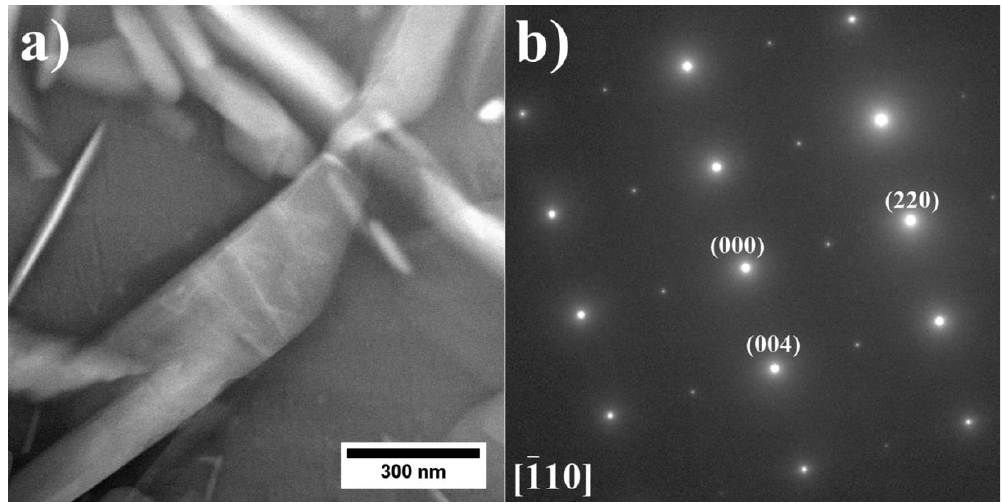
Figure 17. ( a ) Morphology of the η phase precipitate within β -NiAl; ( b ) SAED pattern of the η phase precipitate, STEM-HAADF.